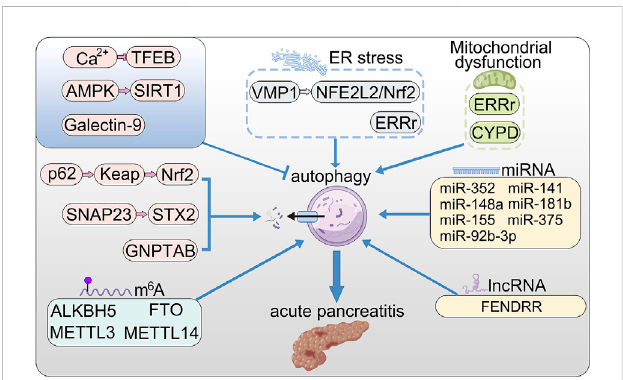
FIGURE 1 The roles of autophagy in AP. VMP1 promotes autophagy via NFE2L2/Nrf2 pathway; ERR γ promotes autophagy by reducing mitochondrial dysfunction and ER stress; Nrf2 promotes excessive autophagy through the p62 – Keap1 – Nrf2 signaling pathway; SNAP23 and STX2 promote autophagy by triggering SNARE complex; store-operated Ca 2+ entry (SOCE) triggers calcium overload and activated TFEB via calcineurin activation, thereby enhanced autophagy; activation of AMPK relieved accumulation of autophagy by up- regulating SIRT1; Galectin-9 binds to Asn 175 of Lamp2 and poly-LacNAc moieties to maintain lysosome function; long non-coding RNA FENDRR positively regulates autophagy through epigenetic suppression of ATG7 by binding PRC2; CypD maintains mitochondrial membrane and positively regulate lysosomal function and autophagy; microRNAs (miRNA) promote the initial stages of